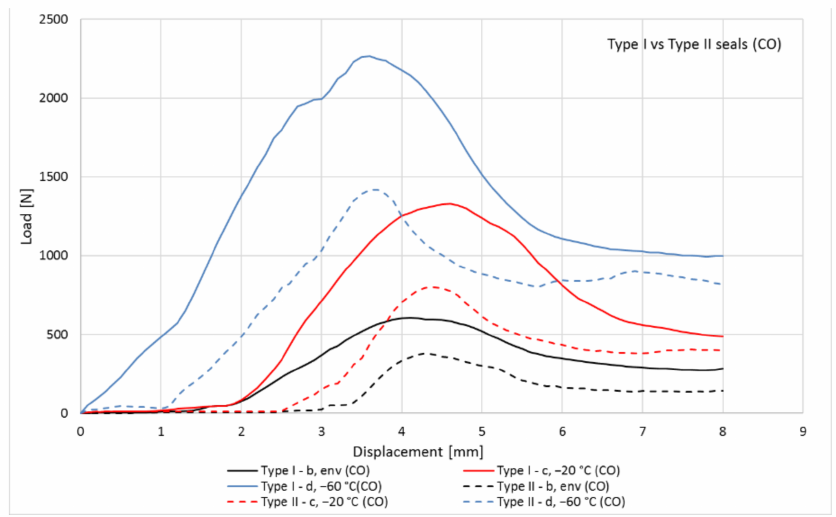
Figure 20. Type I and Type II seals closing forces for the piston with a conical